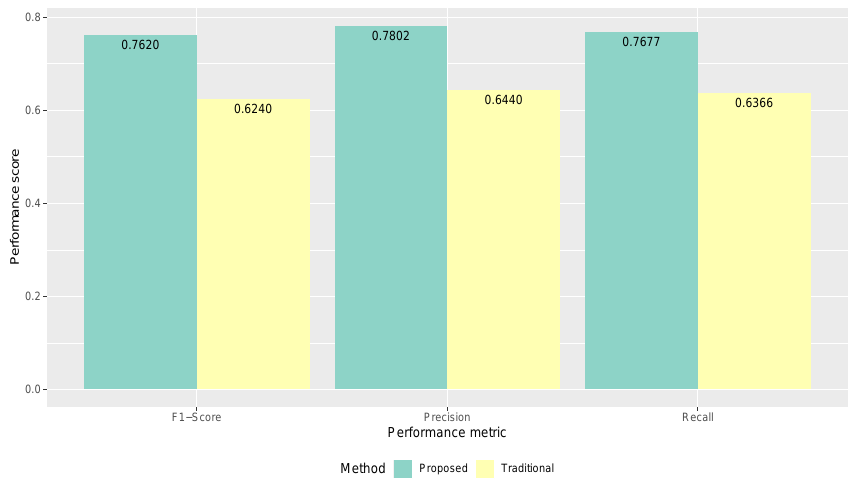
Figure 9. The average classification performance of all models for each method.